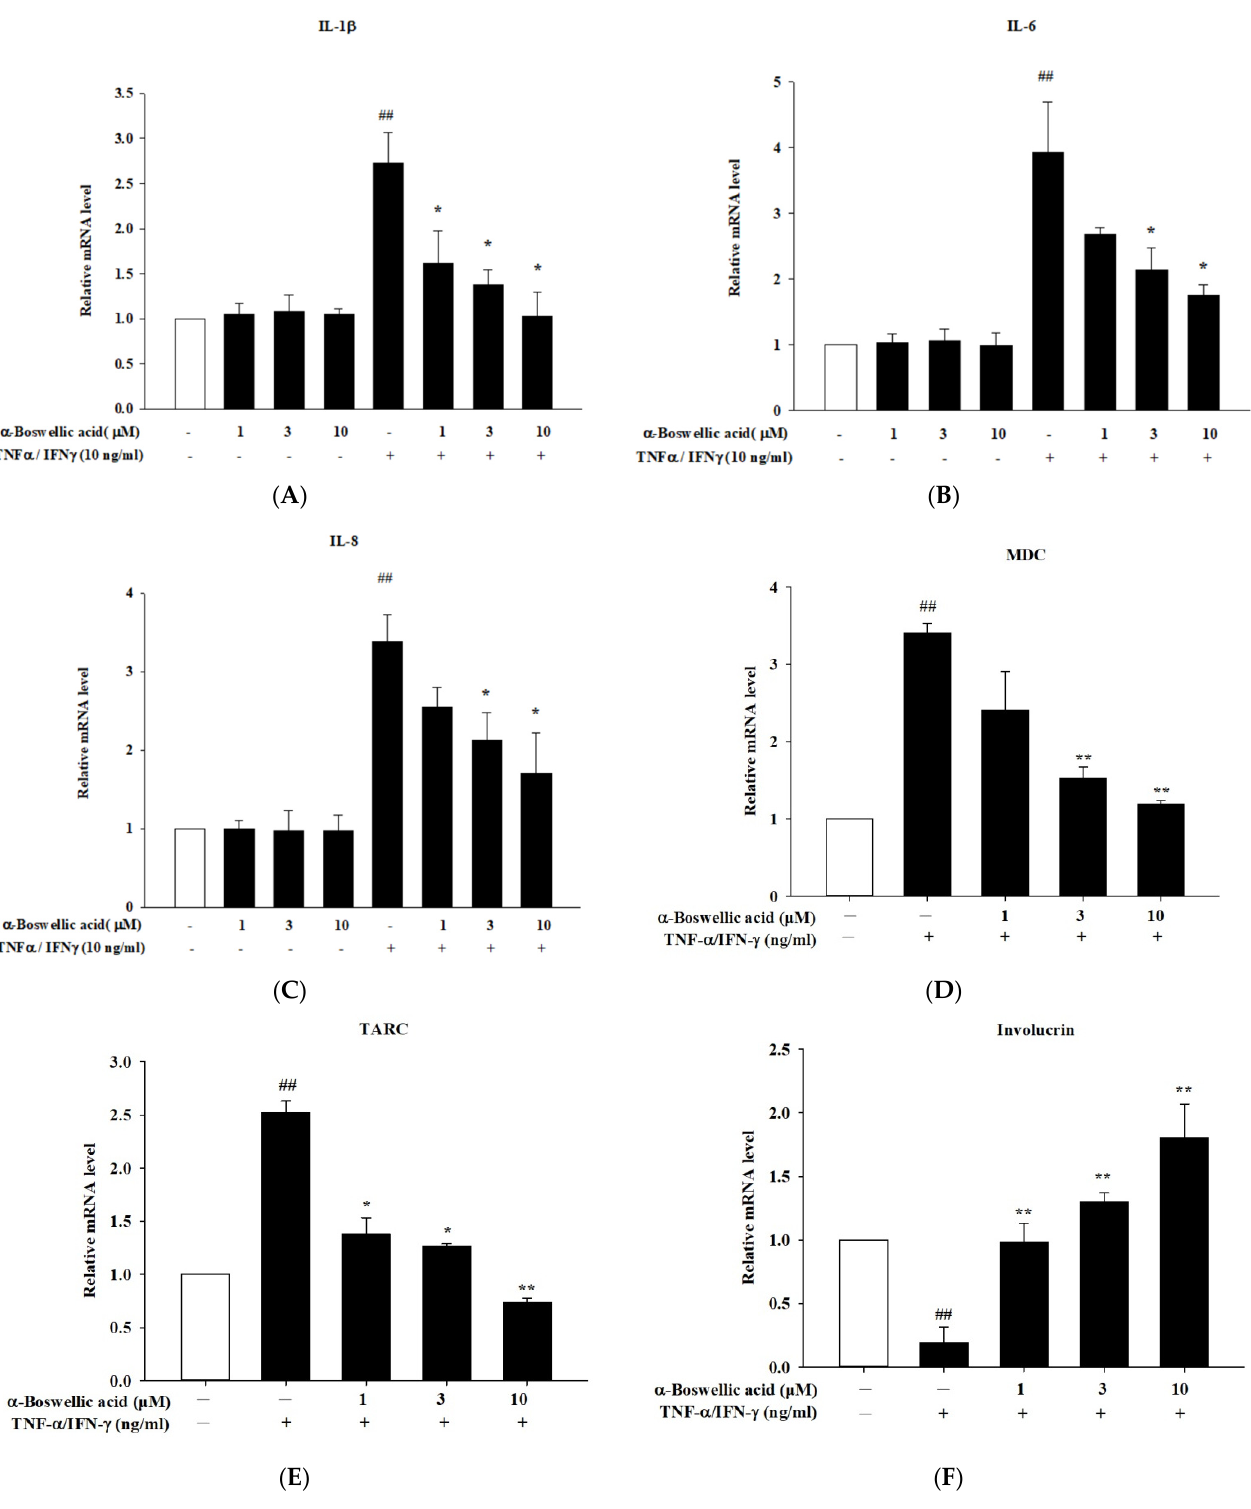
( H ) Figure 3. ( A – E ) Effects of α -boswellic acid on the TNF- α /IFN- γ -induced proinflammatory cytokines and chemokine mRNA expressions in HaCaT cells. ( F – H ) Effects of α -boswellic acid on involucrin, filaggrin, and loricrin mRNA expressions in TNF- α /IFN- γ -induced HaCaT cells. HaCaT cells were pretreated with different concentrations of α -boswellic acid—1, 3, and 10 μ M—for 20 min, and then the cells were treated with TNF- α /IFN- γ for 6 h. Total RNA was isolated and the mRNA expression level of IL-1 β , IL-6, IL-8, MDC, TARC, involucrin, filaggrin, and loricrin were determined using qPCR. Values represent the mean ± SEM from three or four independent experiments. ## p < 0.01 compared with the no-treatment condition; * p < 0.05 and ** p < 0.01 compared with the only TNF- α /IFN- γ treatment condition. 2.4. Effects of α -Boswellic Acid on the MAP Kinase Signaling Pathway in TNF- α /IFN- γ -In- duced HaCaT Cells The activation of keratinocytes by TNF α /IFN γ leads to the activation of the mitogen- activated protein (MAP) kinases signaling pathway and is closely related to the regulation of various responses throughout the downstream [21]. To investigate the anti-inflamma- tory mechanism of α -boswellic acid, we determined the expression of the MAP kinases pathways, which are major inflammatory mediators in atopic dermatitis. Western blot was used to analyze the protein phosphorylation of p38, JNK, and ERK. We found that α - boswellic acid potently inhibited ERK, p38, and JNK protein phosphorylation (Figure 4, left panel). Compared to the ratio of total ERK, p38, and JNK levels, p-ERK, p-p38, and p- JNK were significantly reduced (Figure 4, right panel).